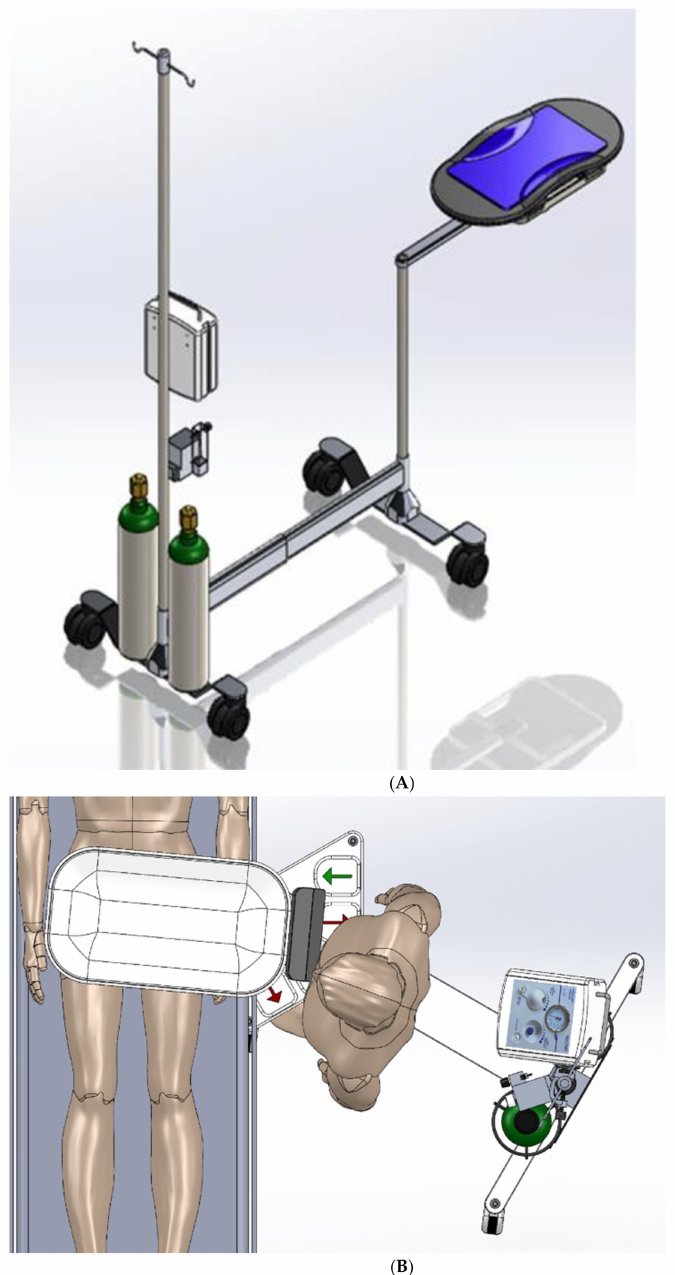
Figure 1. ( A ) Schematic rendering of delayed cord clamping cart. ( B ) Schematic rendering of delayed cord clamping cart cantilevered over patient’s abdomen during